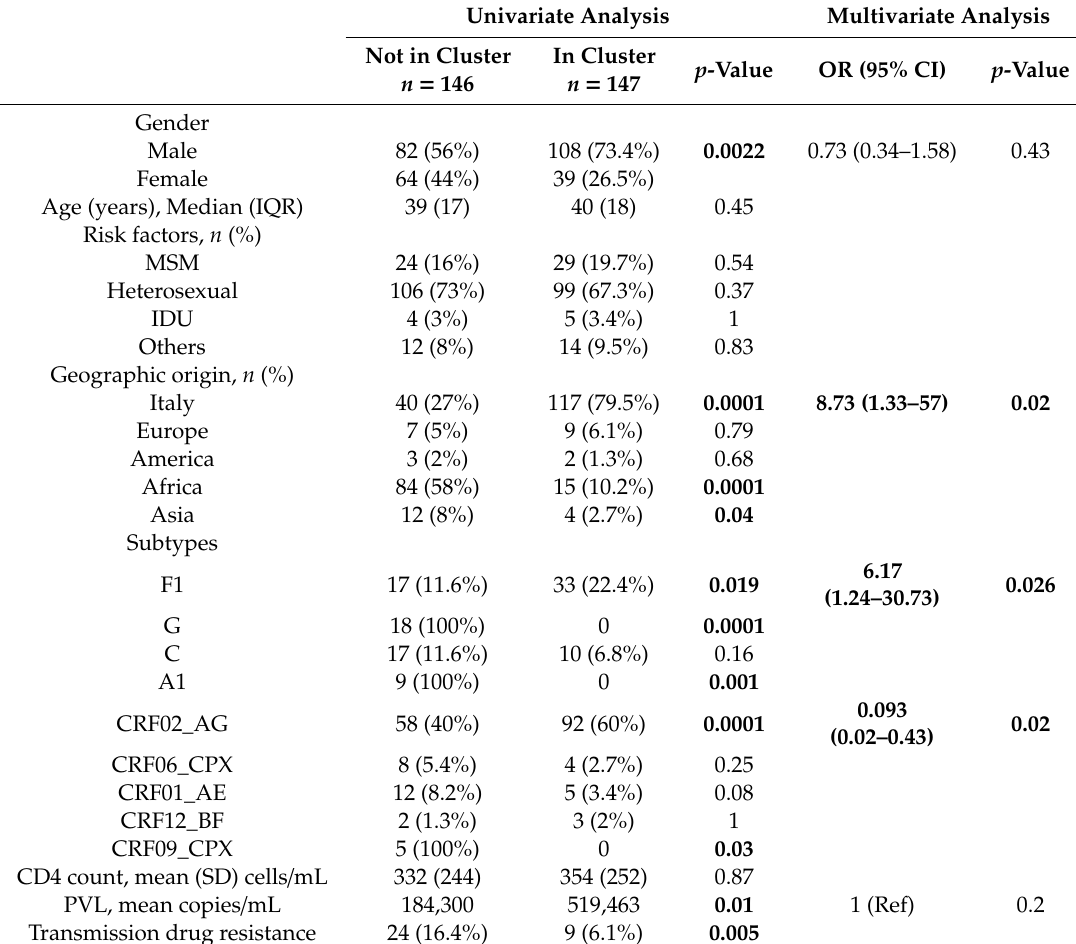
Table 3. Univariate and multivariate analysis for comparison between patients on isolated branches in the phylogenetic tree and patients in phylogenetic